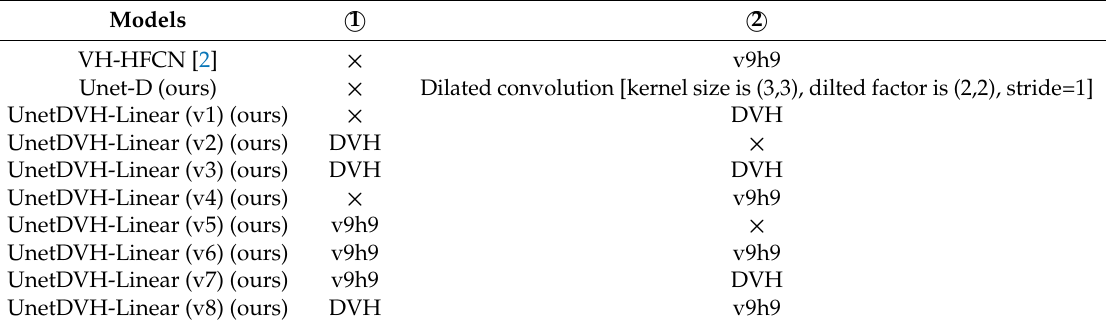
Table 1. Through putting different blocks at 1 (cid:13) and 2 (cid:13) in Figure 1, we can explore how the VH-stage may be applied in the networks by designed different